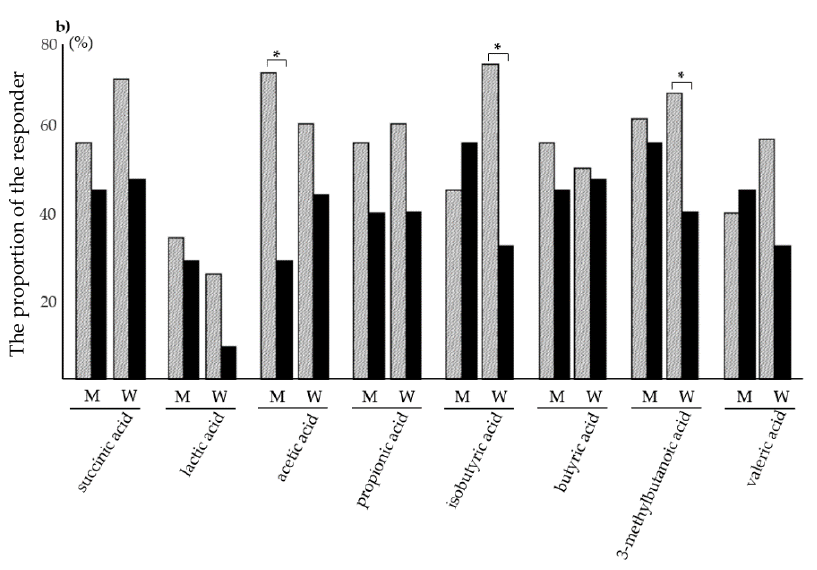
Figure 4. Participants with increased change in eight SCFAs concentrations post-intervention during the study period. Small amounts of formic acid were only detected in five subjects; ad therefore, formic acid was excluded from the analysis. ( a ) The proportion of eight SCFAs was higher in the RDSW group than in the control group. In particular, a significant di ff erence in only acetic acid between the two groups was found. ( b ) The proportion of the participants by sex. Significant di ff erences between men and women were observed in the RDSW group as follows: acetic acid responders in men, and isobutyric acid and 3-methylbutanoic acid responders in women. Hatched bar, RDSW group; black bar, control group; M, men; W, women; * p < 0.05.